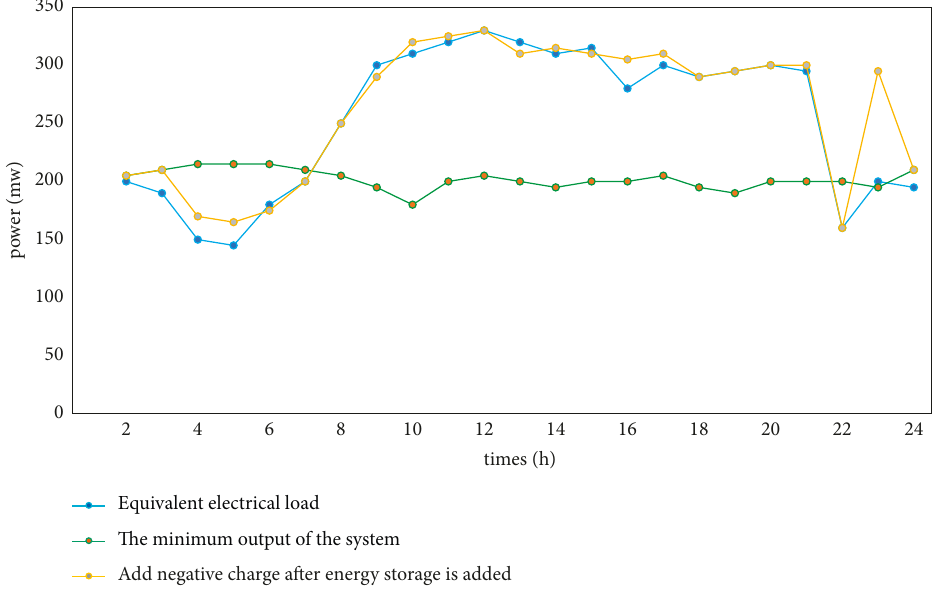
Figure 2: The principle of energy storage device to absorb wind